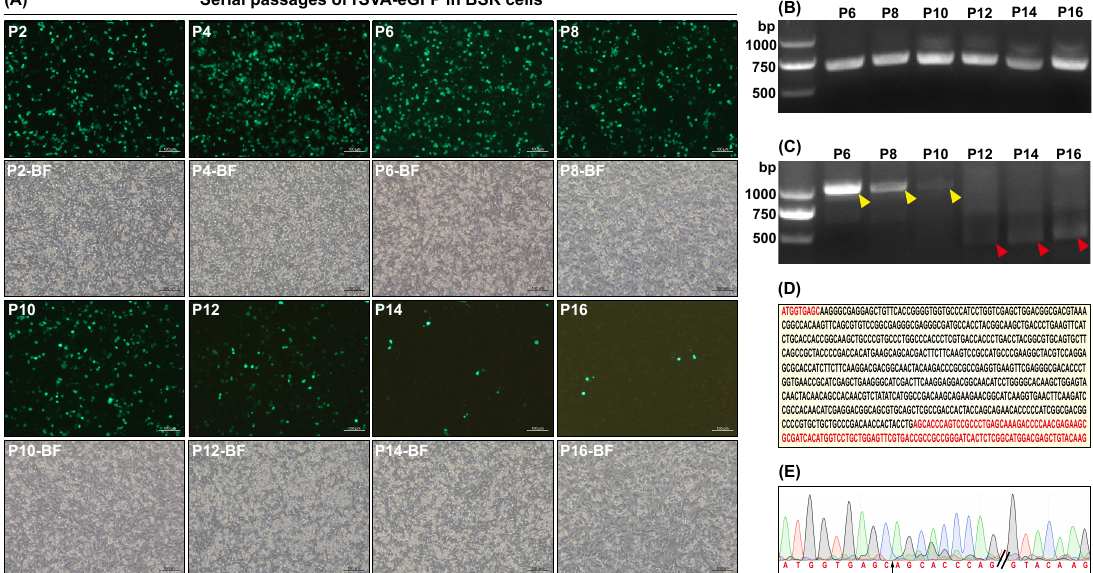
Figure 3. Stability of eGFP expressed by the rSVA-eGFP during serial passaging in BSR cells. Cell monolayers infected with rSVA-eGFP at P2, P4, P6, P8, P10, P12, P14 and P16 at 24 hpi ( A ). RT-PCR analyses of rSVA-eGFP at P6, P8, P10, P12, P14 and P16 using the F1 / R1 ( B ) and the F2 / R2 ( C ) primer pairs, respectively. Brightness of 1004-bp-specific band ( C , yellow arrowhead-marked) is gradually decreasing from the P6 to P10, and finally unobservable from the P12 to P16, whereas another band ( C , red arrowhead-marked) instead gradually becomes bright from the P12 to P16. The ORF sequence of eGFP, from which a 597-bp sequence ( D , black letters) is deleted from the P12 to P16, and which accordingly retains a 120-bp fragment ( D , red letters). Sequencing chromatogram of the P16